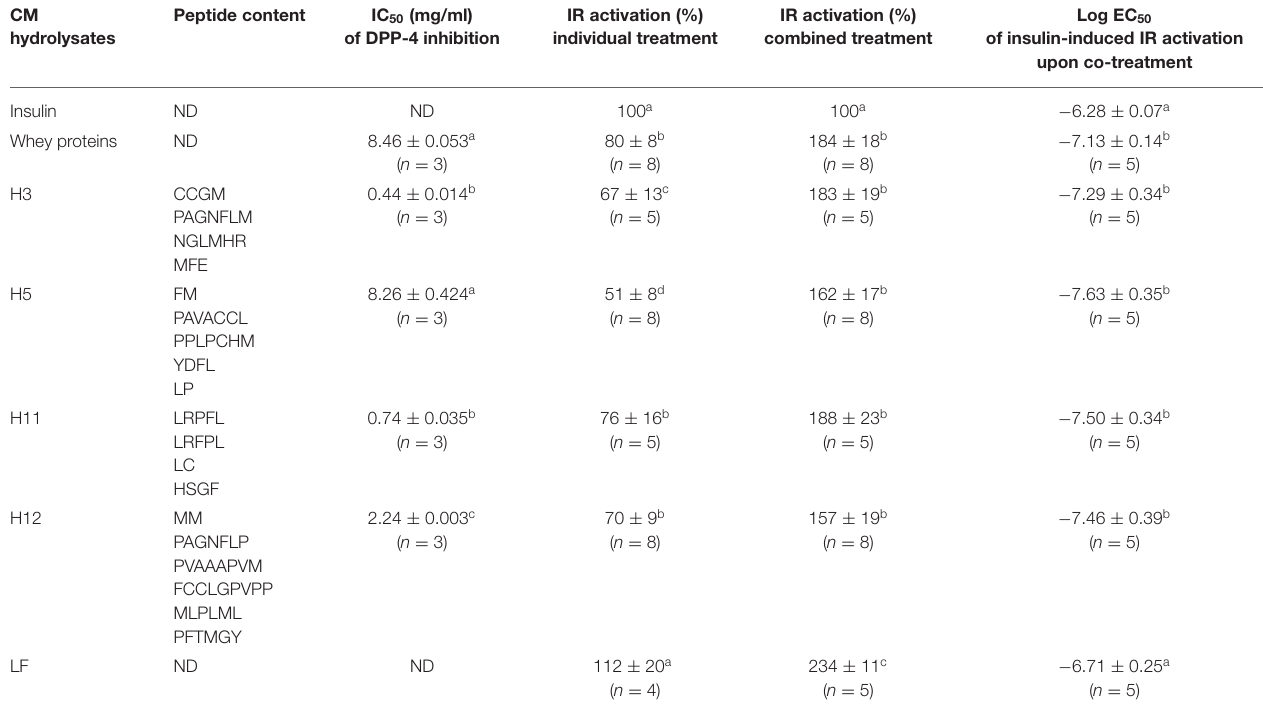
TABLE 1 | Biochemical and pharmacological characteristics of CM hydrolysates and LF purified from CM on DPP-4 inhibition and IR activation and modulation. CM